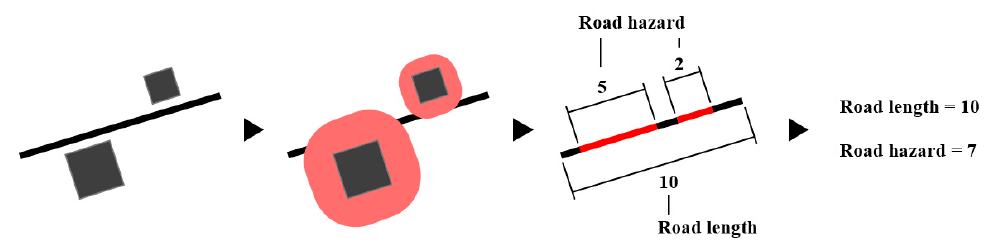
Figure 3. Road hazard analysis.